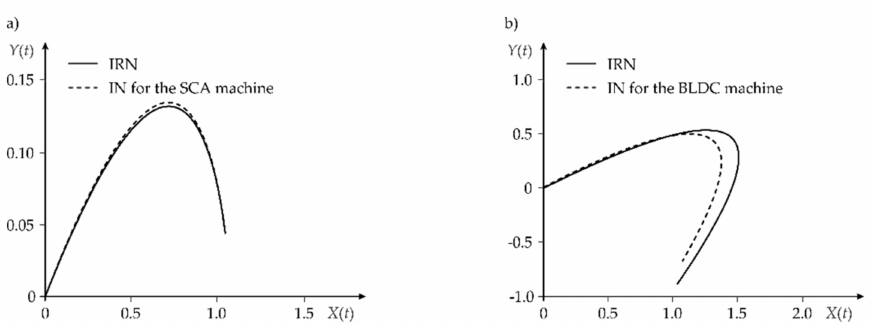
Figure 11. The shape of the nets for one decimal place of accuracy obtained for the SCA machine: ( a ) IN; ( b )